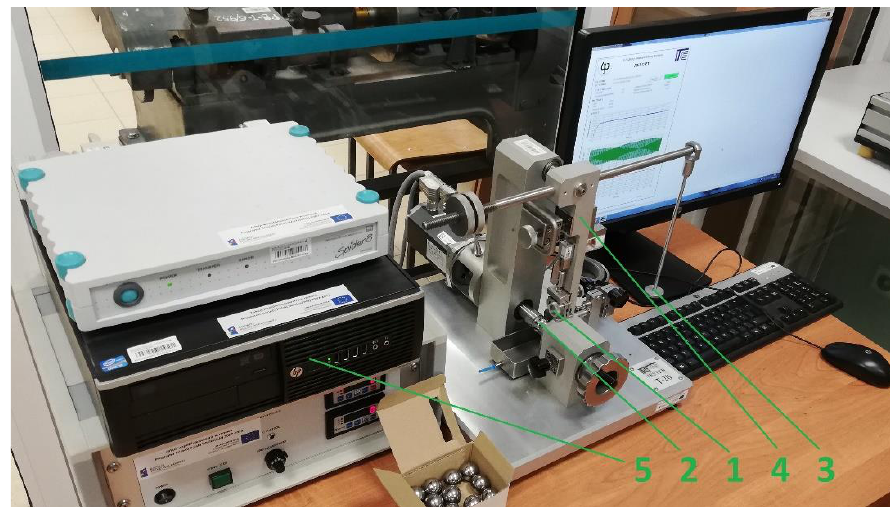
Figure 4. Picture of the T-20 test stand: 1 — sample, 2 — counter-sample (sphere), 3 — load, 4 — swivel leaver, 5 — PC.